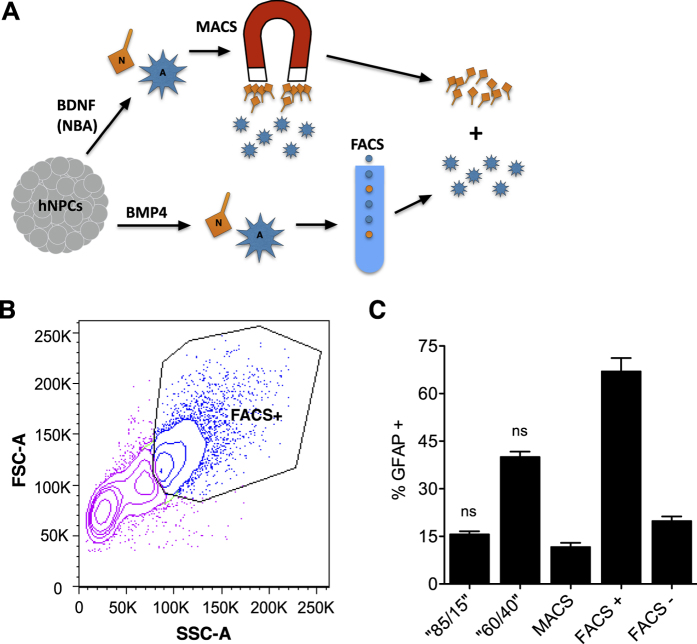
In vitro distribution of GFAP+ hNPC progeny after incrementally mixing BMP4-generated astrocytes with NBA-generated, MACS-purified neurons.(A) Overall experimental design. hNPCs were plated in either the NBA or an alternative, astrocyte-generating assay using BMP4. MACS was used to generate a purified population of neurons (N), while FACS was used to generate a purified population of astrocytes (A). Lastly, purified neurons and astrocytes were re-combined in defined percentages. (B) FACS gating strategy to enrich the BMP4-induced hNPC progeny for astrocytes, using SSC vs. FSC to select the largest 25% of cells (FACS+). (C) Quantification of GFAP-immunolabeled cells indicates that the targeted cell phenotype distributions (85% neurons: 15% astrocytes, 60% neurons: 40% astrocytes) were achieved (no statistically significant difference between actual and targeted values). The MACS column represents the purified neuron population, while the FACS+ and FACS− columns represent the larger (targeted for selection) and smaller (not targeted for selection) cohorts of the BMP4-generated cells, respectively. Not significant (ns). Means + s.e.m. *P < 0.05, by unpaired two-tailed t test.